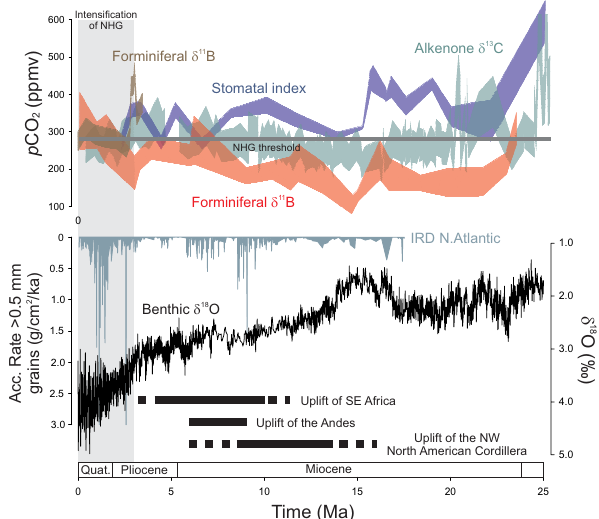
Figure 1. Foster et al. Fig. 1. Miocene, Pliocene and Quaternary p CO 2 (top) and climate records. The atmospheric concentration of CO 2 (top) during this time period is reconstructed using stomatal index of fossil leaves (blue; K¨urschner et al., 2008; K¨urschner et al,. 1996), the δ 13 C of marine alkenones (green; Pagani et al., 1999; Pagani et al., 2009) and the δ 11 B of marine planktic foraminifera (red – Pearson and Palmer, 2000; brown – Seki et al., 2010). The threshold p CO 2 value necessary for sustained glaciation in the Northern Hemisphere is shown as a horizontal grey band (DeConto et al., 2008). Also shown is a record of ice rafted debris (IRD) in the North Atlantic (middle; ODP Site 151-909; Winkler, 1999) and the global compi- lation of benthic foraminifera δ 18 O of Zachos et al. (2008; bottom). The vertical grey bar shows the time period when there was sus- tained glaciation in the Northern Hemisphere, note the sharp decline in δ 18 O and increase in IRD at this time. Also shown by horizon- tal black bands are the timing of uplift of the NW North Ameri- can Cordillera as reviewed here as well as Andean (Garizone et al., 2008) and SE African uplift (Sepulchre et al., 2006 and references there